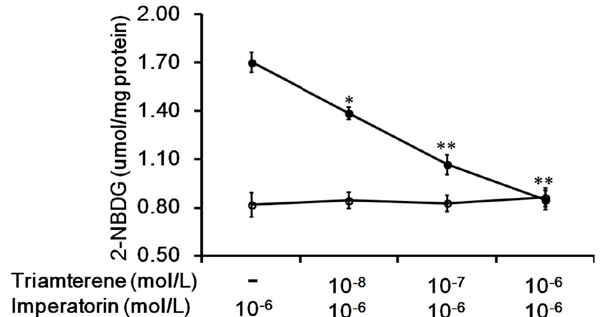
Figure 2. Triamterene inhibits the increased glucose uptake induced by imperatorin in TGR5-transfected cells. The imperatorin-induced increase in glucose uptake (2-NBDG) in cells. The imperatorin-induced increase in glucose uptake (2-NBDG) in TGR5-transfected CHO-K1 TGR5-transfected CHO-K1 cells (TGR5-CHO-K1 cells) was reduced by triamterene in a cells (TGR5-CHO-K1 cells) was reduced by triamterene in a dose-dependent manner (black circle). dose-dependent manner (black circle). However, treatment with triamterene at the same effective However, treatment with triamterene at the same effective dose did not modify spontaneous glucose dose did not modify spontaneous glucose uptake (open circle). "-" is presented as 0 mol/L. Values uptake (open circle). “-” is presented as 0 mol/L. Values (mean ± SEM) were obtained from eight (mean ± SEM) were obtained from eight measurements in each group. measurements in each group. * p < 0.05 and ** p < 0.01 compared with imperatorin-stimulated